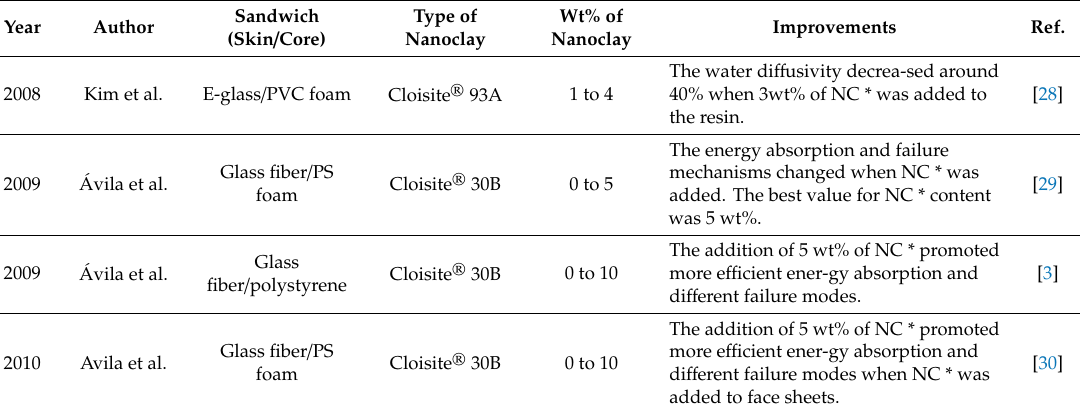
Table 2. Summary of the benefits obtained with nanoclays added to the